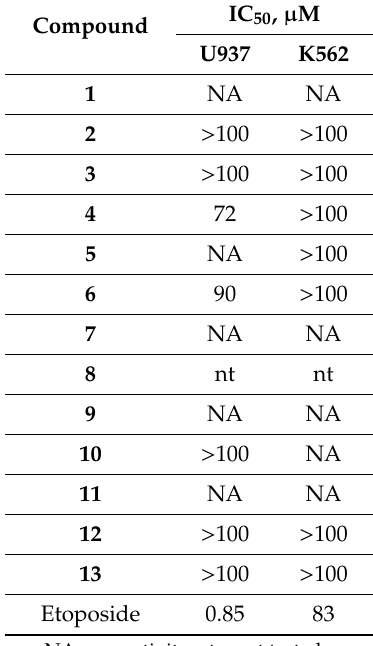
Table 5. Cytotoxic activity of isolated compounds 1 – 13